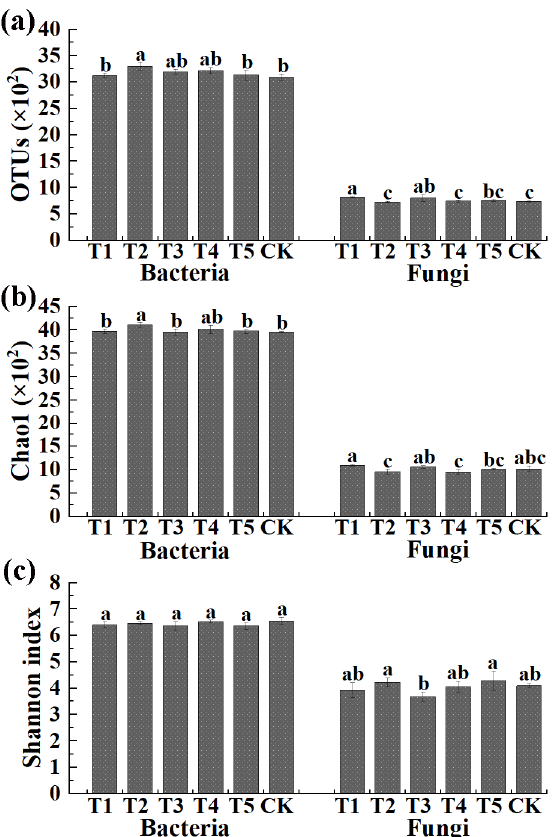
Figure 2. Effects of different microbial fertilizers on the OUT distribution ( a ), the Chao1 index ( b ) and the Shannon’s diversity index ( c ) of bacteria and fungi in corn rhizosphere soil. T1, T2, T3, T4, T5, and CK represents the treatment of Tuzangjin microbial fertilizer (TMF), carbonergic microbial agent (CMA), seaweed microbial fertilizer (SMF), sheep manure (SM), chemical compound fertilizer (CCF), and the control (CK), respectively. Values with different lowercase letters within the same treatments indicate significant differences ( p < 0.05).